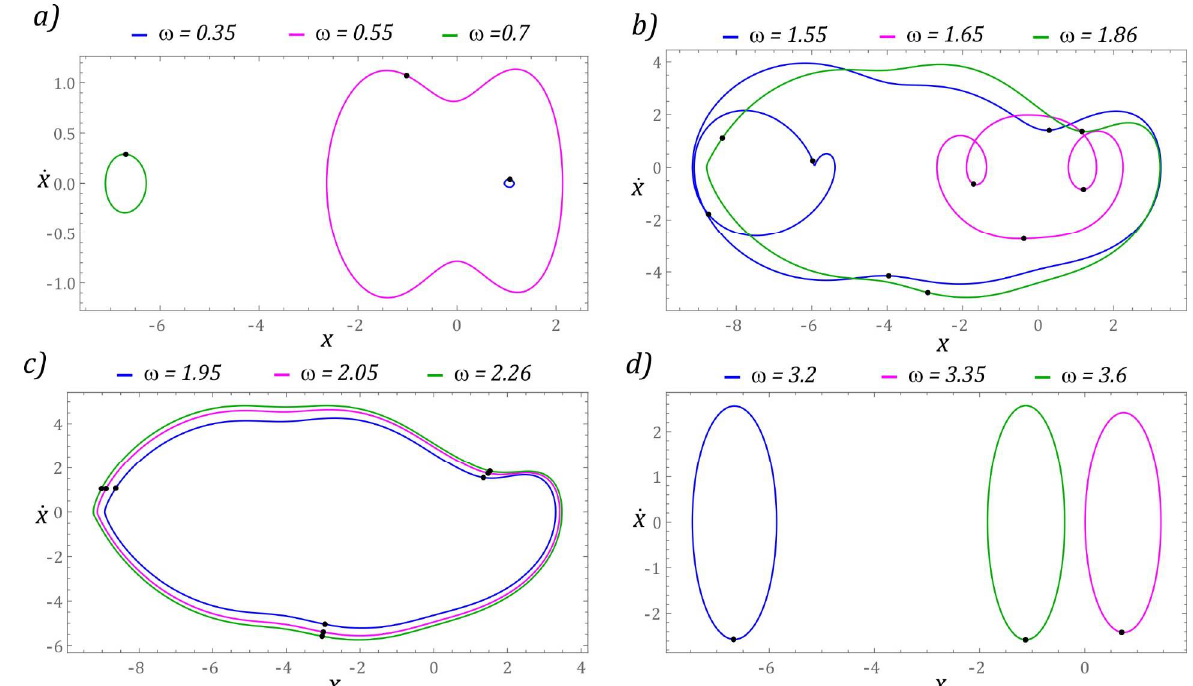
Figure 16. Sample graphic images of periodic solutions. The cases ( a – d ) show the selected solutions for increasing ω . The corresponding Poincaré maps with multiple black points ( b , c ) indicate higher period solutions.